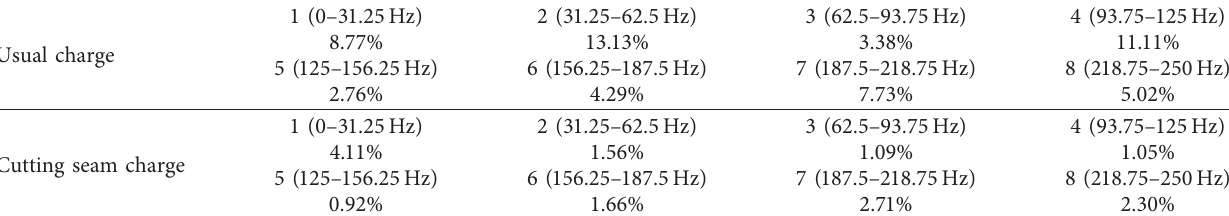
Figure 7: Energy percent distribution diagram of the usual charge and cutting seam charge during 250 Hz. 1: 0–31.25 Hz, 2: 31.25–62.5Hz, 3: 62.5–93.75Hz, 4: 93.75–125 Hz, 5: 125–156.25Hz, 6: 156.25–187.5 Hz, 7: 187.5–218.75Hz, and 8: Table 3: Energy proportion of 8 frequency bands within 250Hz.